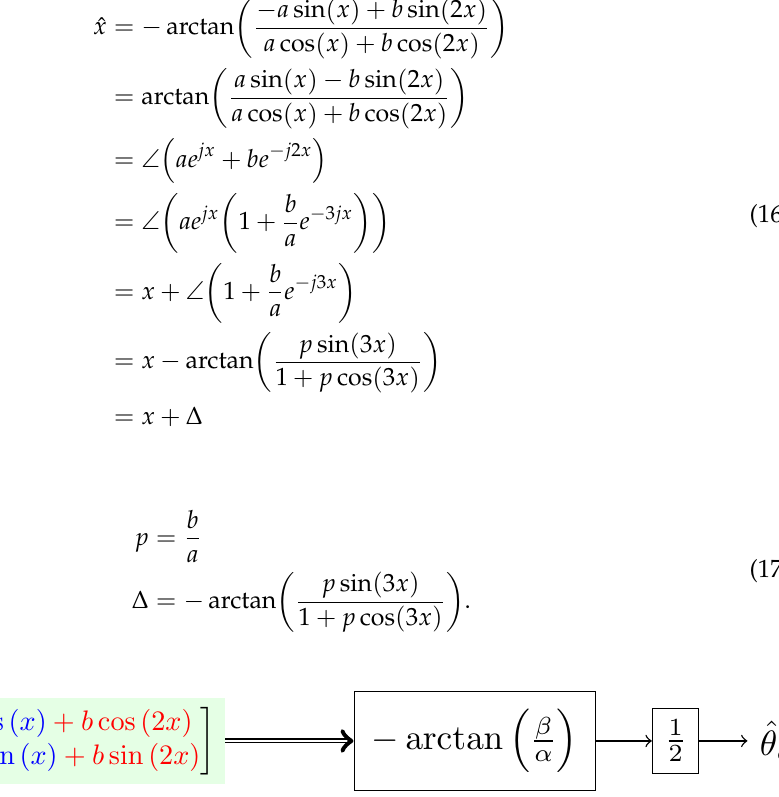
Figure 3. Flowchart of the position estimation procedure using the DFC signals Γ α and Γ β